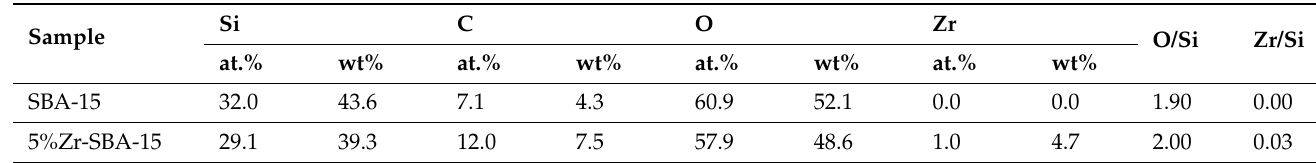
Table 2. Catalyst surface chemical composition determined via